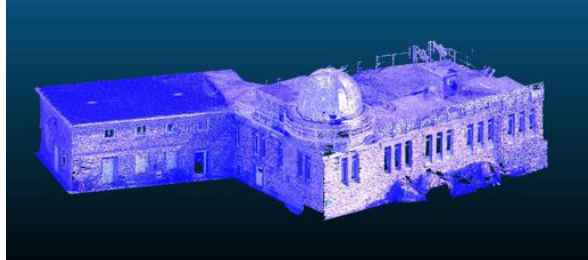
Figure 5. A segmentation of the Vaussenat